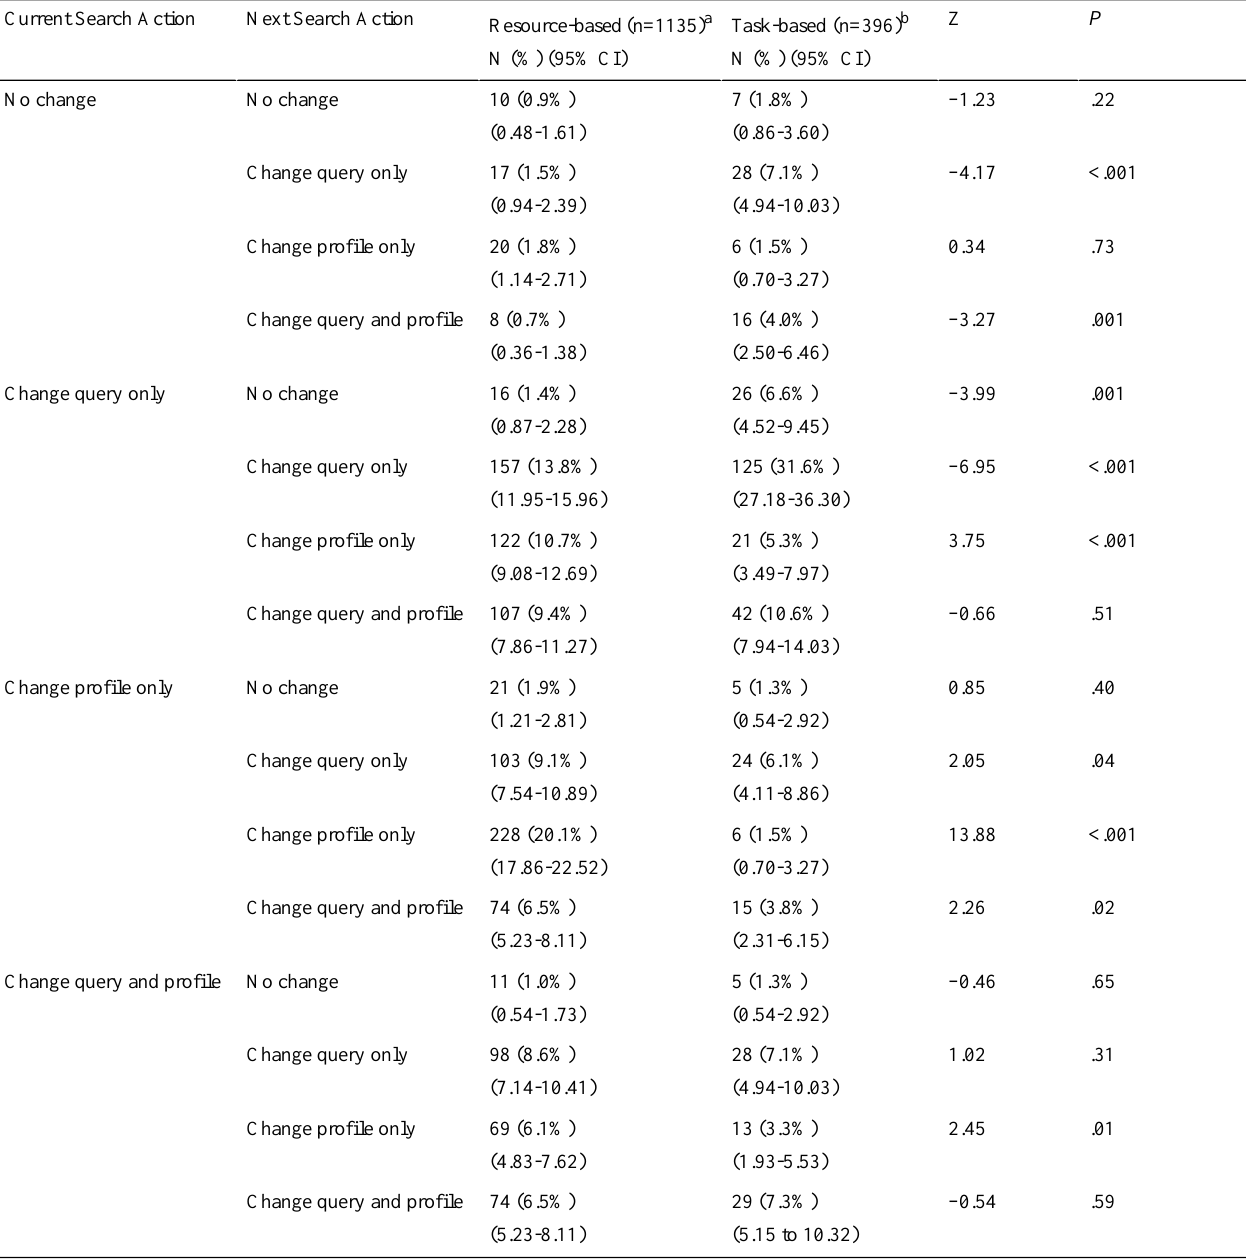
Table 7. Consecutive search actions in a session between resource-based and task-based